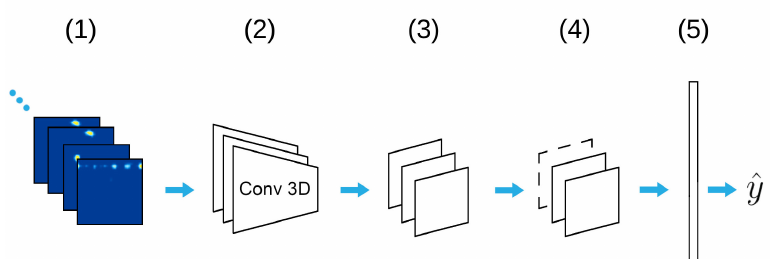
Figure 3. Conv3D deep learning model architecture. Range Doppler images (1) are processed with a stack of Conv3D layers (2) with kernel size 2 × 2 × 2 that extracts feature maps followed by 3D maxpooling (3) and spatial dropout (4) layers. Layers (2)–(4) are stacked in blocks of 32, 64, 128, and 256 units. Then, a fully connected layer creates feature vectors, which are fed into the softmax layer (5) for class prediction ( ˆ y ).